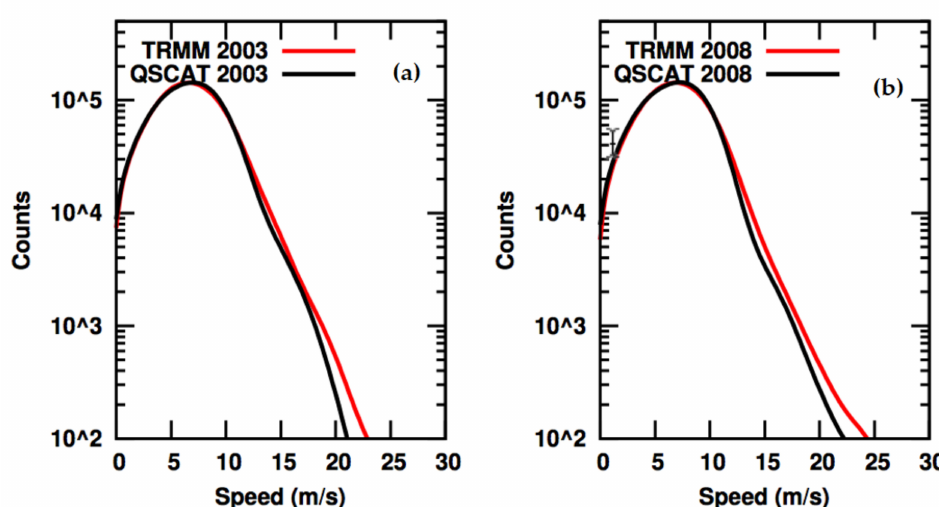
Figure 1. Individual wind speed histograms resulting from all 15-min coincidences between TRMM and QuikSCAT during ( a ) 2003 and ( b ) 2008, under rain-free